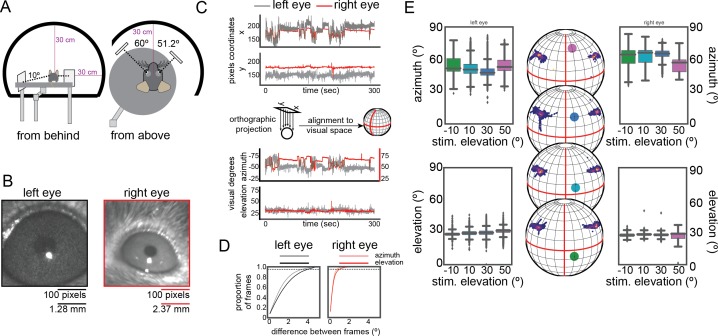
Eye position during performance of the change detection task at four elevations.(A) Schematic depicting the geometry of the eye tracking and immersive display system. The mouse was centered in the display sphere to aid in estimation of gaze in visuotopic coordinates. Infrared dichroic mirrors were placed in front of each eye as depicted. (B) Example images from the pupil tracking of the left eye (left) and the right eye (right). For the right eye (C) Example traces depicting sensitivity of the eye tracking system and the amplitude of typical movements, in both pixels coordinates of the eye tracking images (top) and following conversion to visual coordinates (bottom). The conversion is schematized between the plots, showing an orthographic projection of the pixel coordinate system in to spherical coordinates, which are then aligned to the visual coordinate system based on the geometry depicted in panel A. (D) Estimate of the resolution of each eye tracking image, showing that 95% of frame-to-frame changes are < 1° for the right eye and < 4° for the left eye. (E) Eye position across the four elevation conditions. The elevation and azimuth are not statistically different between any pair of conditions (p>0.05, t-test, box plots). For each elevation, the center position of an ellipse fit to the pupil is shown projected into visual coordinates, with the color of each point representing the density of overlapping points.